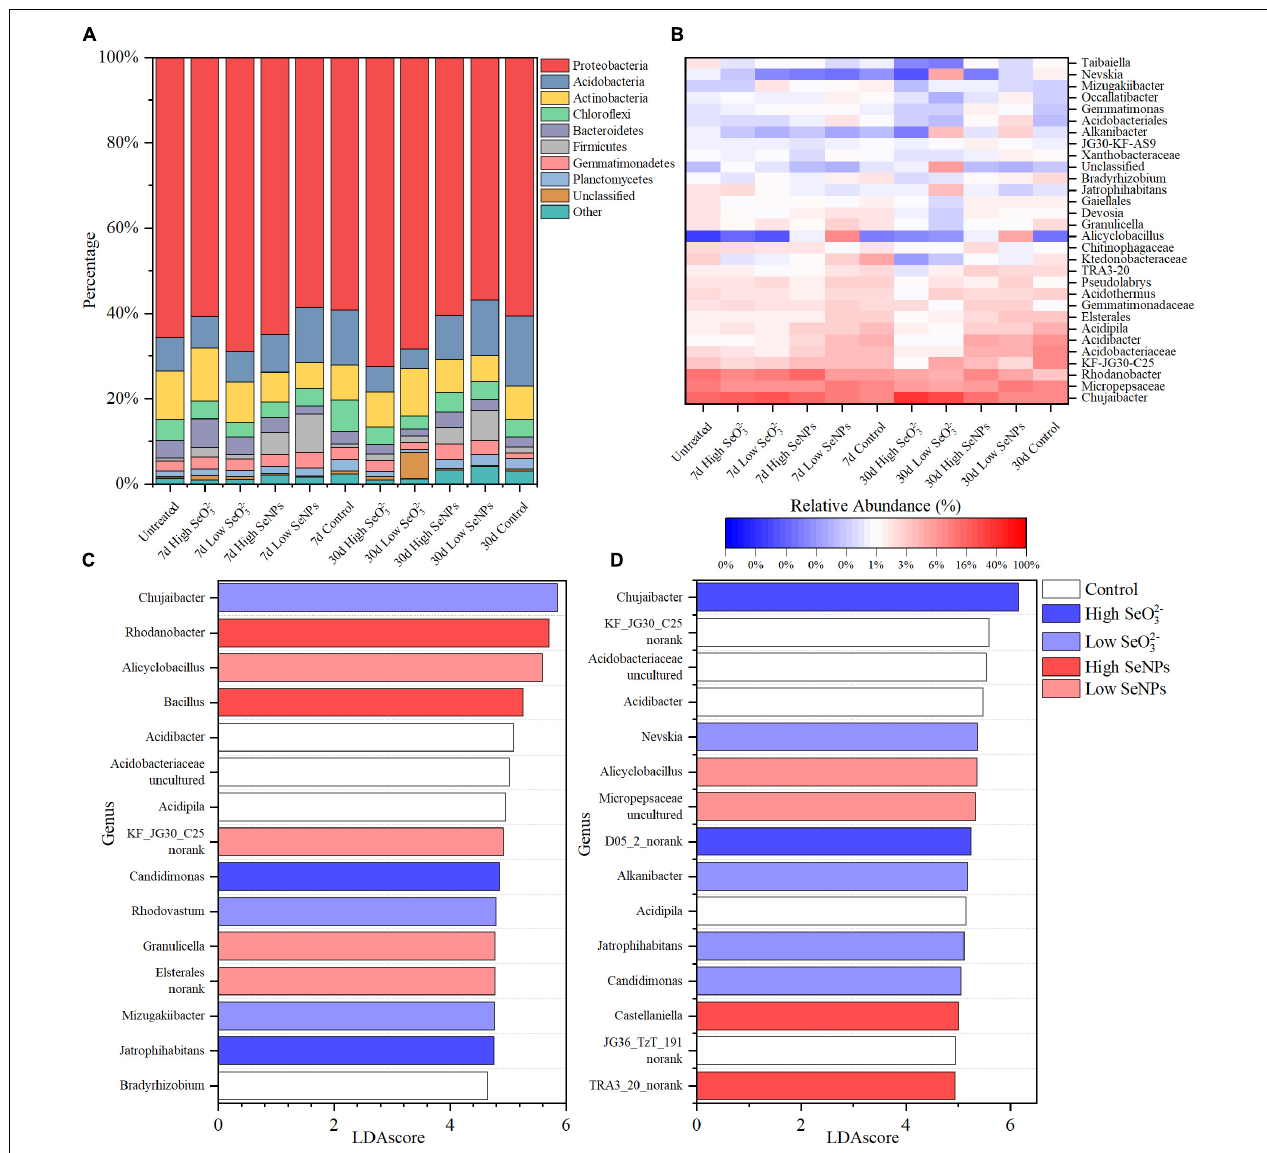
FIGURE 3 | Taxonomy composition of the microbiota in each experimental group. (A) The relative abundance of major bacteria phyla. (B) The relative abundance of major bacteria genera. (C,D) The top 15 significantly changed genera identified by linear discriminant analysis effect size (LEfSe) on Days 7 (C) and 30 (D) . Control: the samples collected from the control group without selenium (Se) treatment. High selenite (SeO 32 - ): the samples collected from the group treated with 10 mmol/kg soil SeO 32 - . Low SeO 32 - : the samples collected from the group treated with 1 mmol/kg soil SeO 32 - . High selenium nanoparticles (SeNPs): the samples collected from the group treated with 10 mmol/kg soil SeNPs. Low SeNPs: the samples collected from the group treated with 1 mmol/kg soil SeNPs.